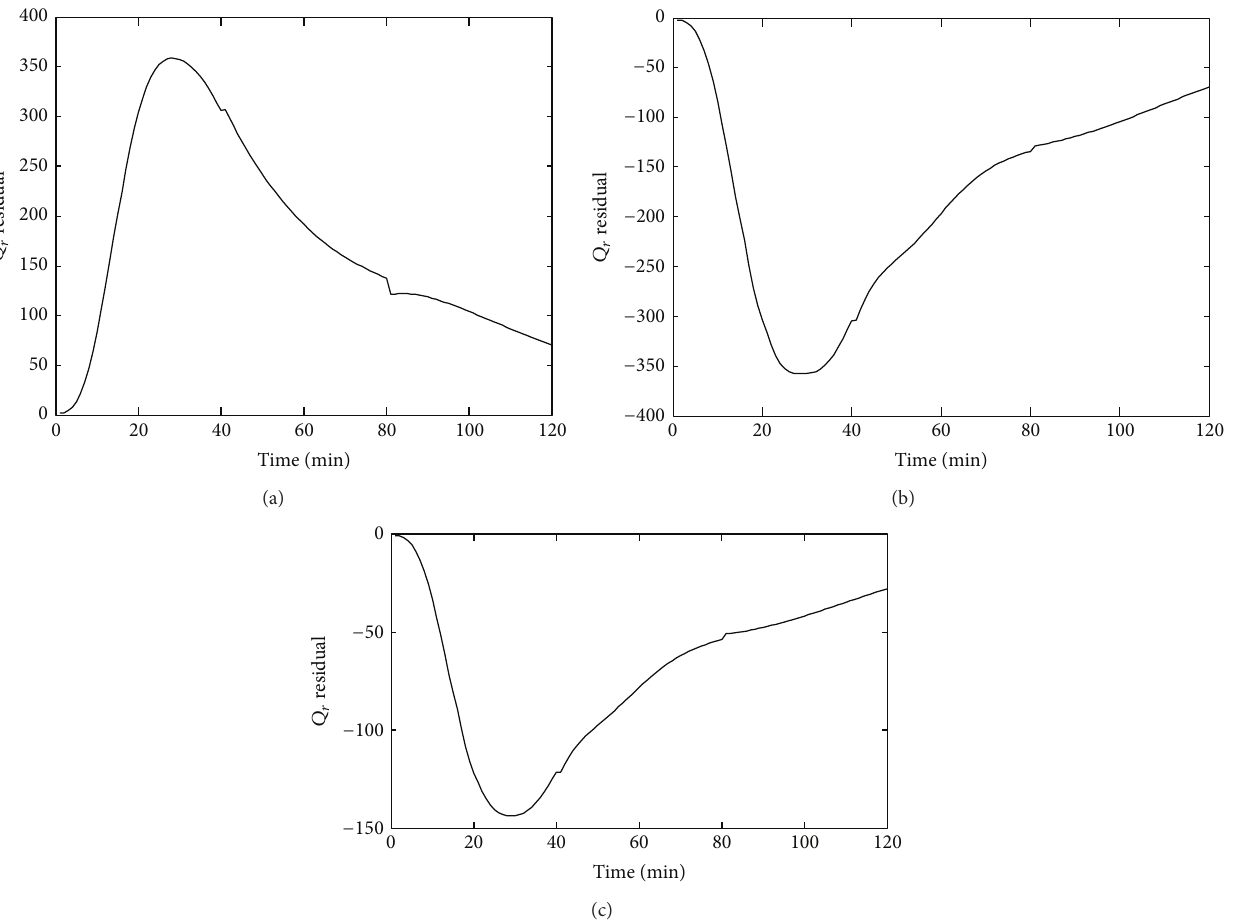
Figure 10: Residual (in terms of 𝑄 𝑟 ) due to change in heat of reaction. (a) Residual (in terms of 𝑄 𝑟 ) due to 25% decrease in heat of reaction. (b) Residual (in terms of 𝑄 𝑟 ) due to 25% increase in heat of reaction.(c) Residual (in terms of 𝑄 𝑟 ) due to 10% increase in heat of reaction.